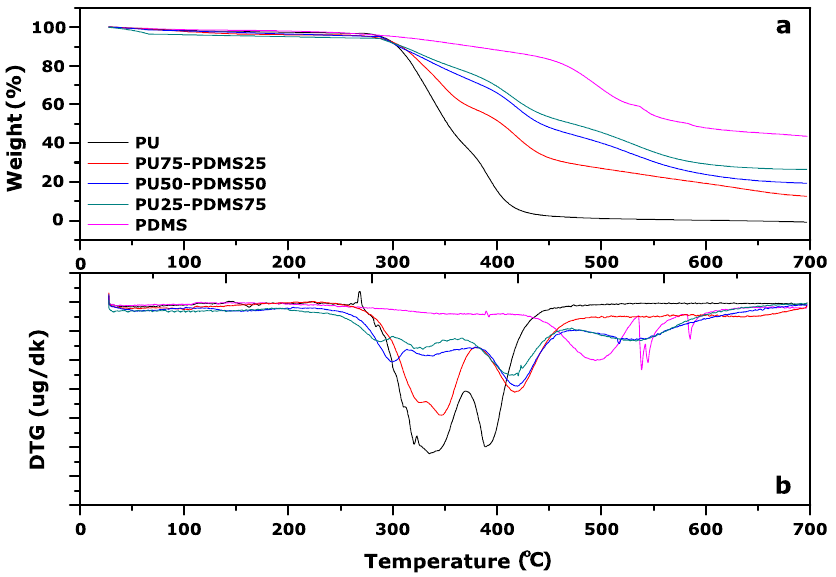
Figure 12: TGA ( a ) and DTG ( b ) analysis of PU – PDMS